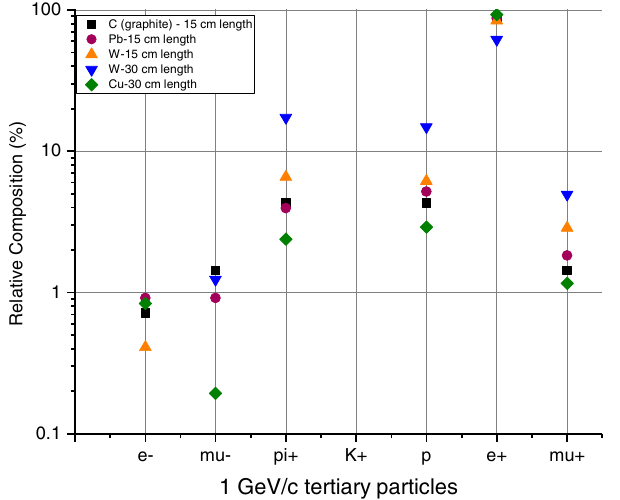
FIG. 2. Target optimization simulations, performed with G4beamline . It is shown that 30 cm of tungsten provides better absorption of the positrons, thus leading to an increased relative amount of pions and protons for the low energy beams of 1, 2 and 3 GeV =c , as discussed in the text.